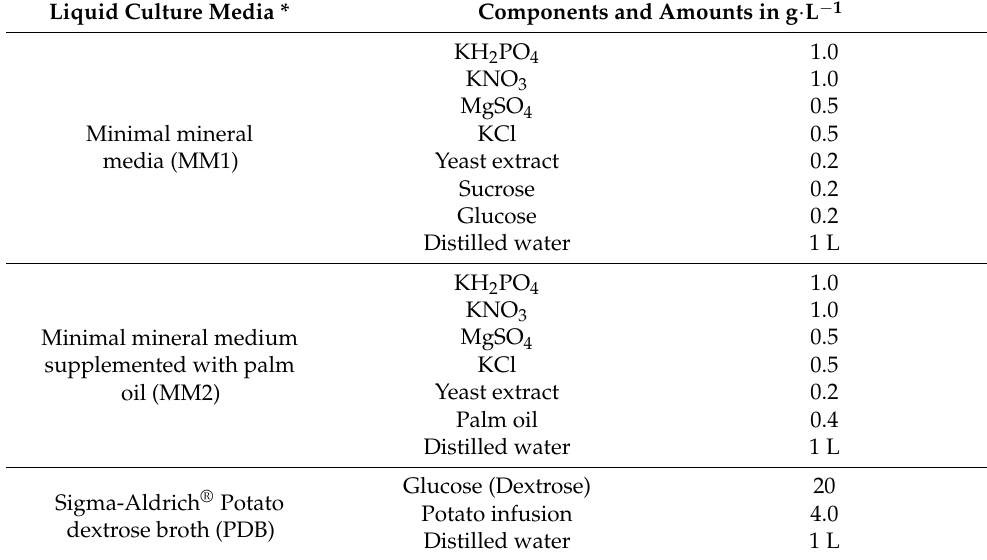
Table 3. Culture media used in the PET depolymerization